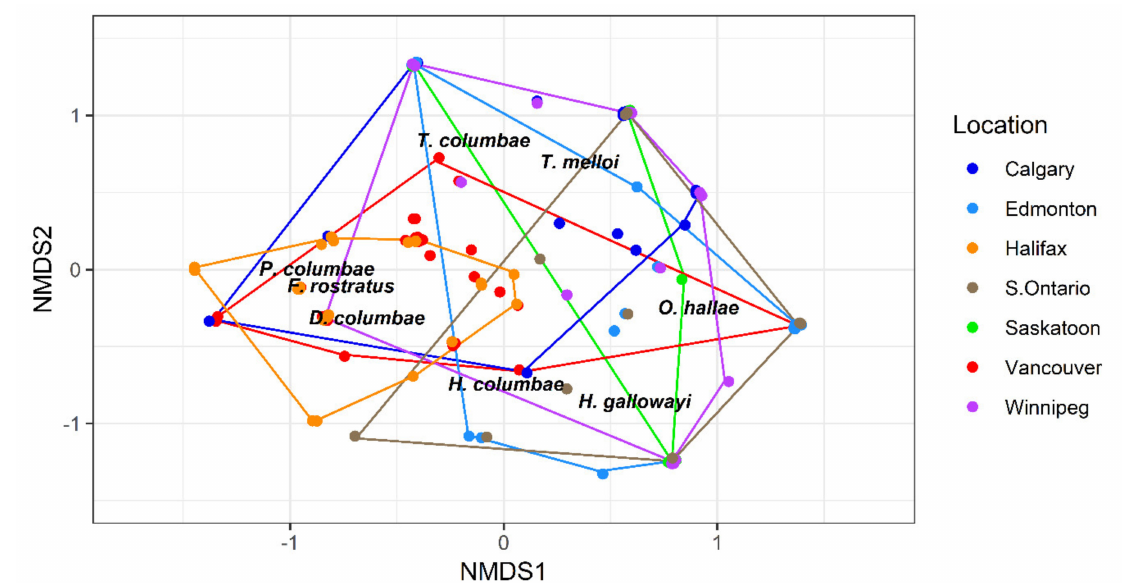
Figure 6. Non-metric multidimensional scaling plot of mite assemblages (presence-absence data) infesting Columba livia (n = 162) sampled from seven locations across Canada. Locations of mite names indicate the direction of their vectors. Stress = 0.1180, points have been jittered (width = 0.02, height = 0.02) to minimize visual overlap. Vancouver mite as- semblages are significantly different from every other location except Halifax and Halifax was different from every other location other than Vancouver.